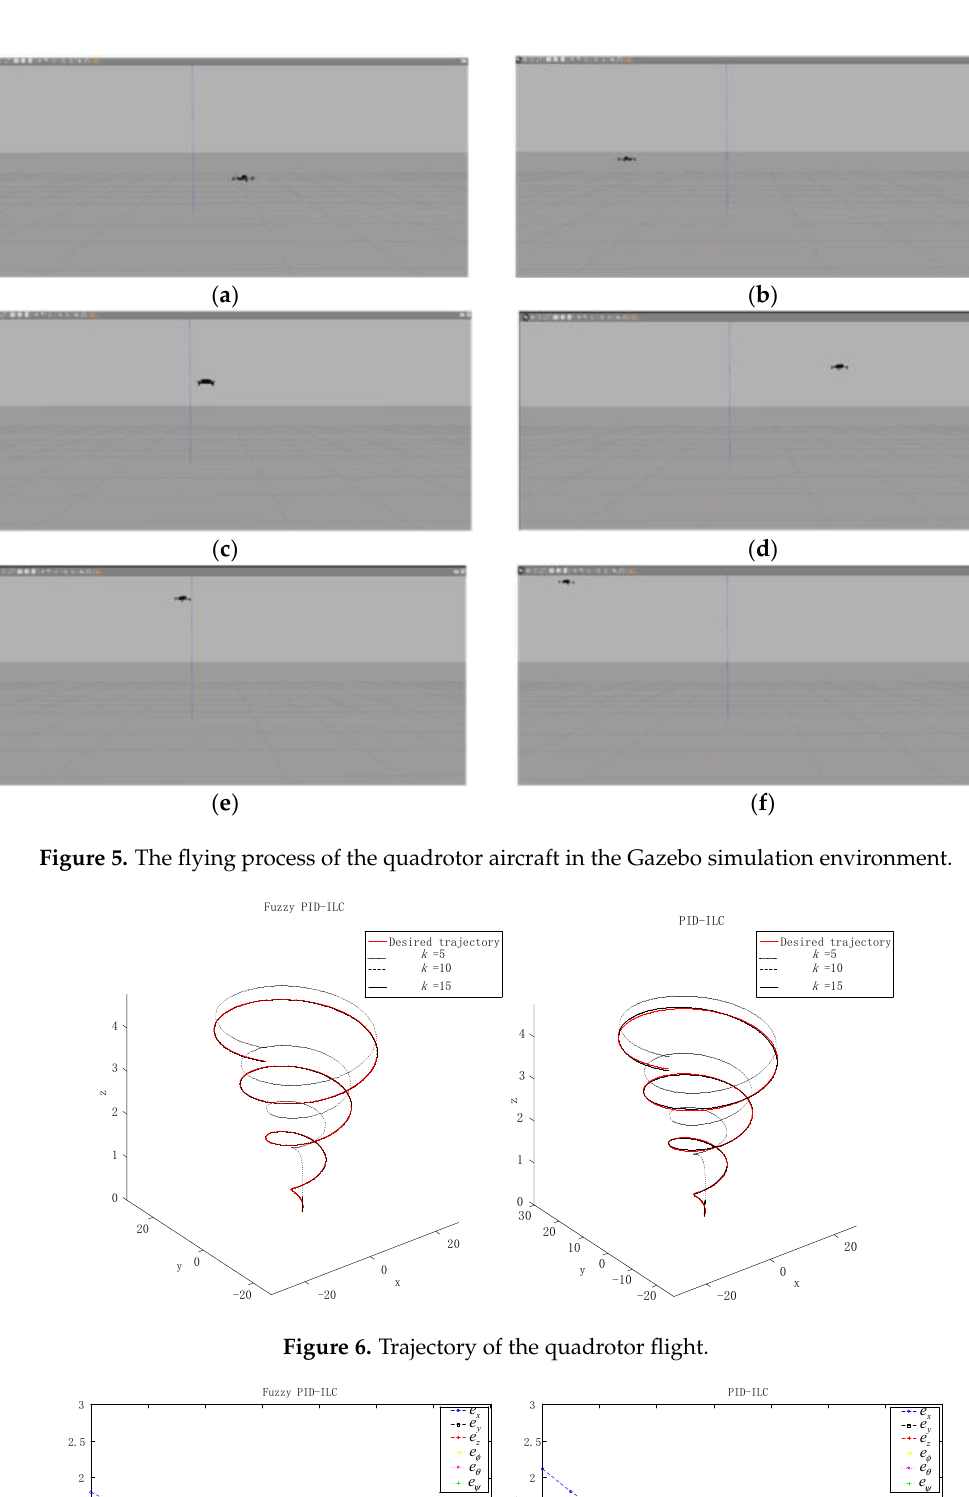
Figure 7. Maximum absolute values of the tracking error.